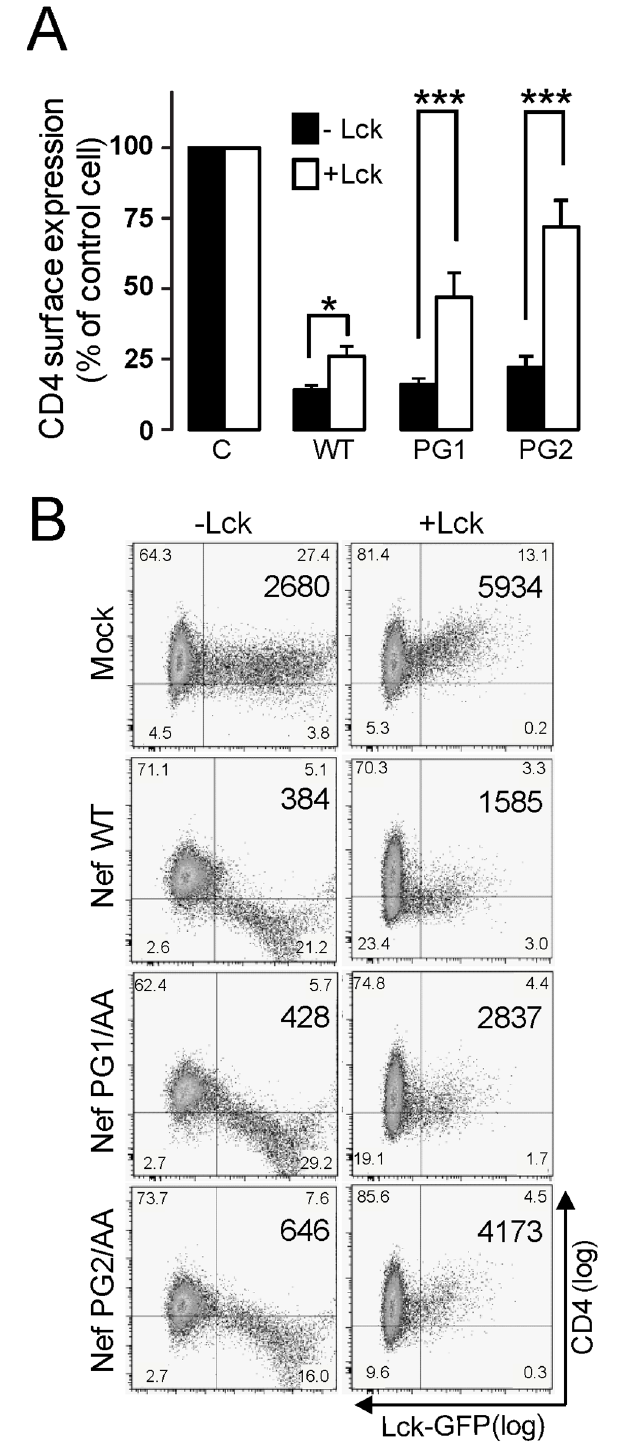
Fig 3. The integrity of the GPG-motif is dispensable for Nef-induced CD4-downregulation in p56 Lck -negative cells. A) HeLa-CD4 cells were co-transfected with the wild type or the indicated Nef-GPG mutants (Nef-HA) along with empty or p56 Lck -GFP constructs. Nef activity on CD4-downregulation was analysed by two-colour flow cytometry in GFP cells. A) Histograms represent the percentage of CD4 expression at cell surface relative to non-transfected cells. n.s, not statistically significant. *** , p < 0.001. B) Dot plots and the corresponding MFI are representative of three independent